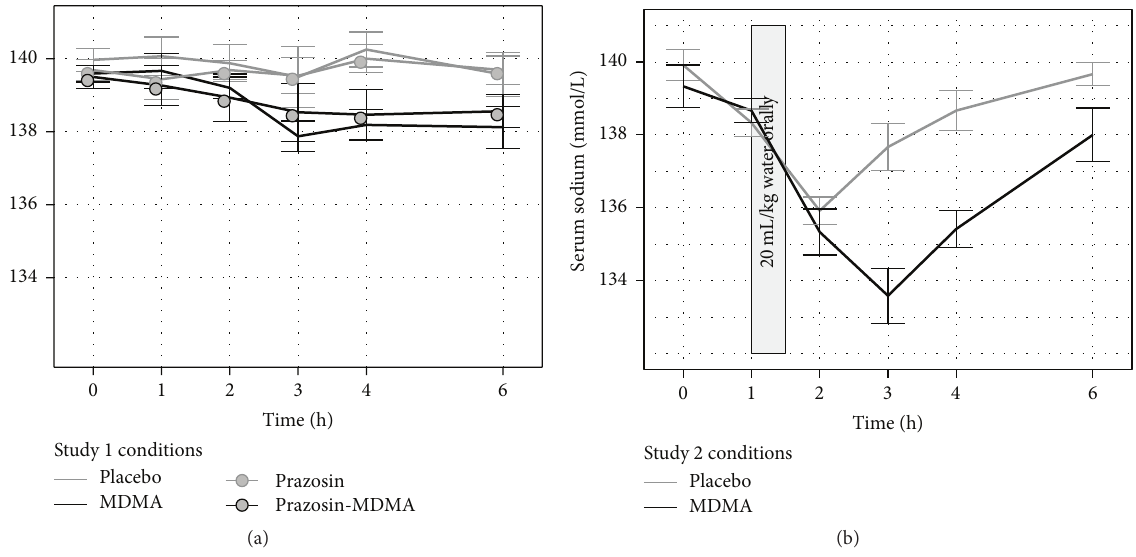
Figure 3: Serum sodium changes over time during Studies 1 (a) and 2 (b).